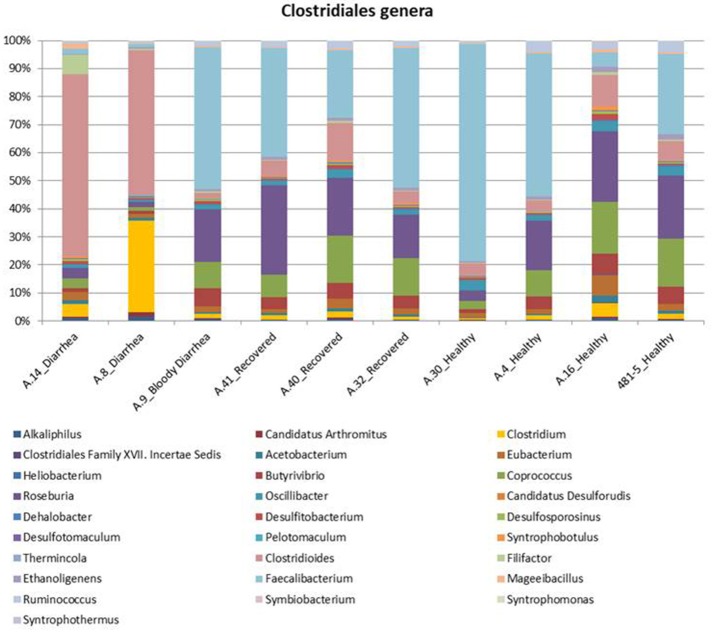
Distribution of the main genera belonging to the Clostridiales order in the metagenomes from the STEC O26 outbreak, obtained through the analysis based on read mapping. The scale on the y axis refers to the percentage of the reads mapping to the specific OTU.